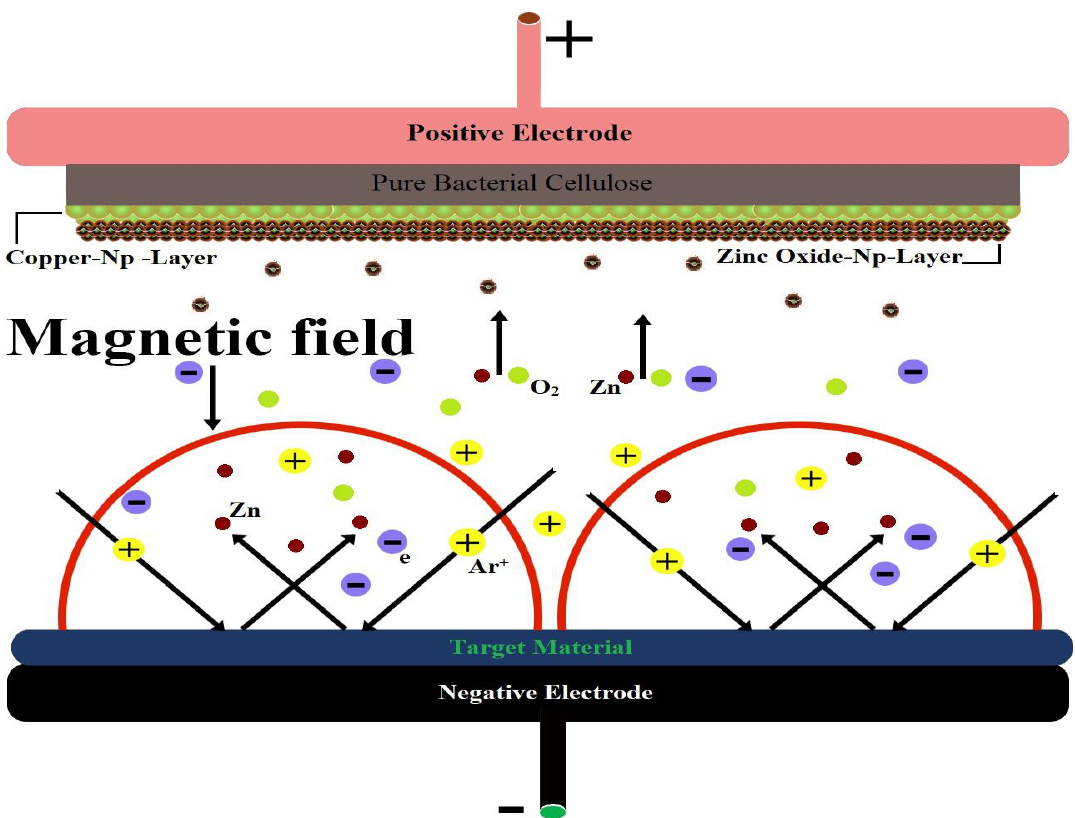
Figure 2. The process of the formation of copper and zinc oxide nanoparticles over the surface of pure bacterial cellulose by (DC and RF) magnetron sputter coating method.